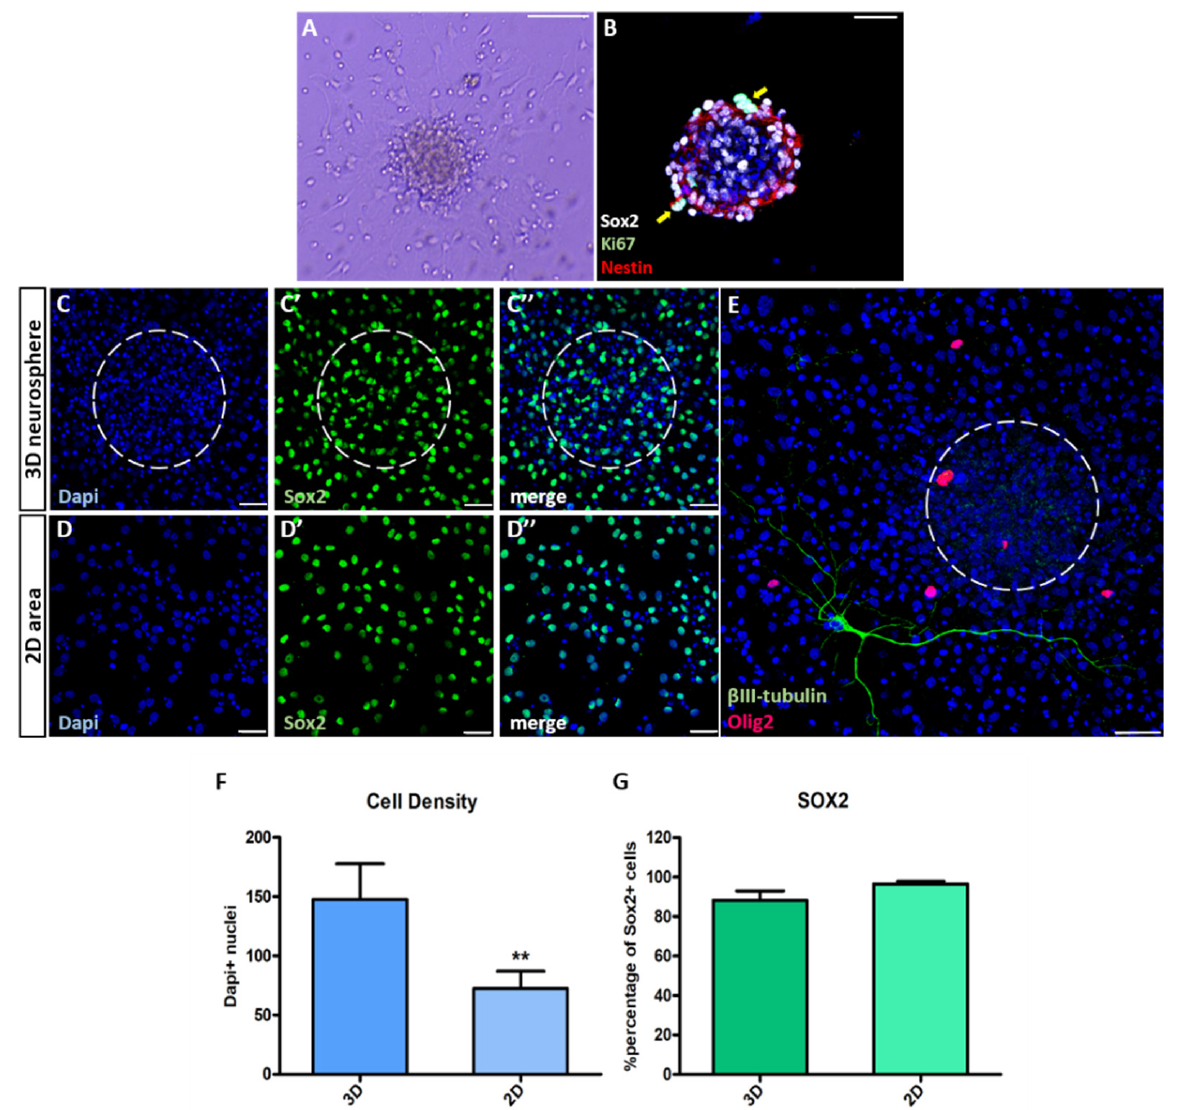
Figure 1. A polymorphic neurosphere assay of postnatal NSCs with a range of cytoarchitectures. ( A ) Representative brightfield image of a neurosphere in differentiation conditions. Note the cells having migrated out of the sphere, creating a 2D, monolayer, microenvironment. ( B ) Image of a neurosphere immunostained for Sox2, Nestin (neural stem and progenitor cell markers) and Ki67 (proliferation marker). The arrows indicate proliferating stem and progenitor cells (Nestin + Sox2 + Ki67+). ( C , D ) Representative images of 3D ( C ) and 2D ( D ) microenvironments of the polymorphic NSC assays after 7d in differentiation conditions immunostained for Sox2. ( E ) Representative image of an immature neuron ( β III+) at the periphery of a neurosphere and of oligodendrocyte lineage cells (Olig2+) inside and outside of the neurosphere. Note the absence of co-expression of markers of the two lineages. ( F , G ) Graphs showing total cell density ( F ) and the percentage of Sox2+ cells (in G ), comparing between 3D and 2D microenvironments. [** p < 0.01, using paired t -test, n = 5–7. Error bars: SEM. Scale bars, ( A ): 60 µ m, ( B – E ): 30 µ m; delineated areas indicate where spheres were anchored. Also, note the high numbers of nuclear fragments, typical of apoptotic cells, observed as very dense DAPI+ structures. These were not counted as DAPI+